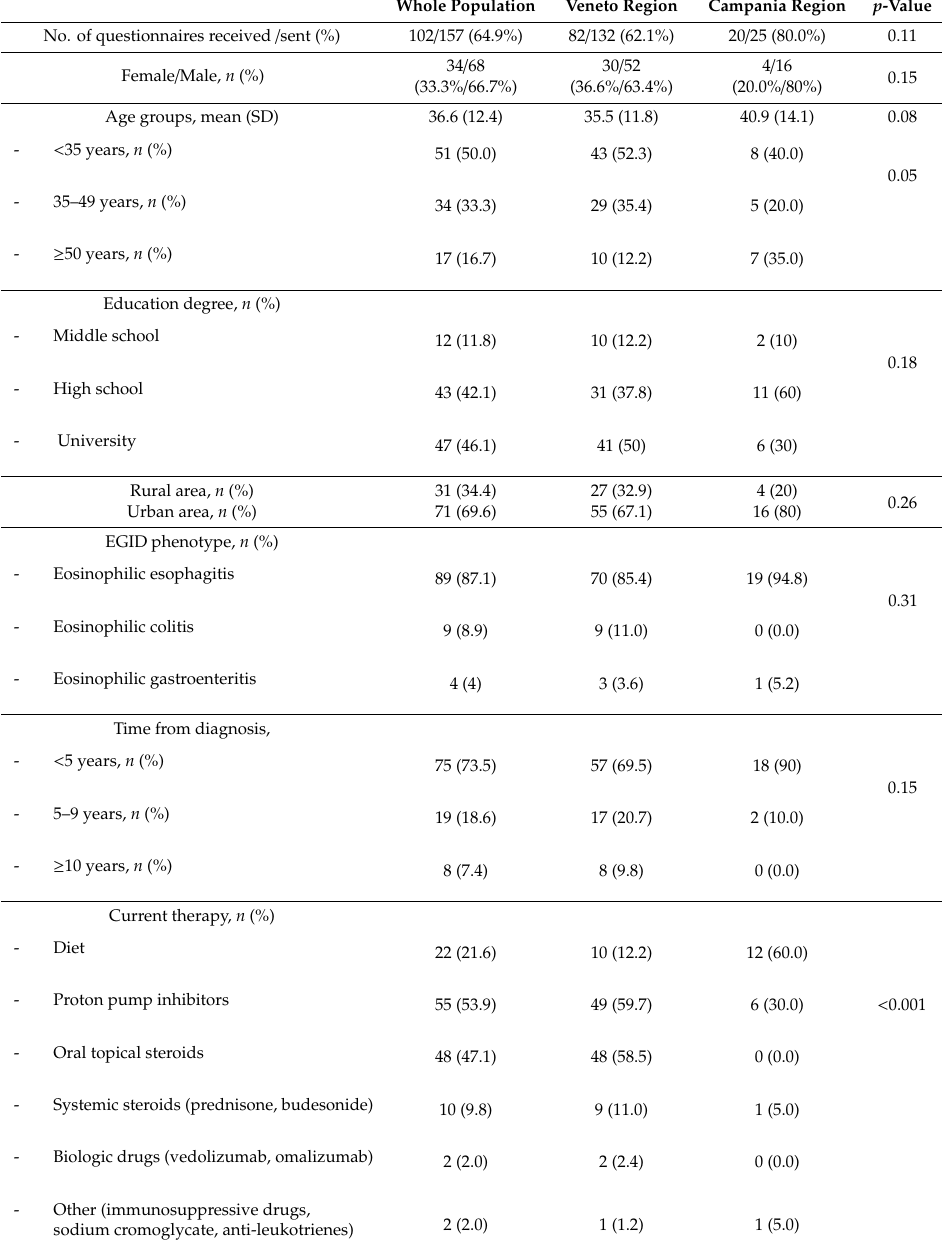
Table 1. Demographic and clinical characteristics of eosinophilic gastrointestinal disease (EGID) patients stratified per each Italian region. Whole